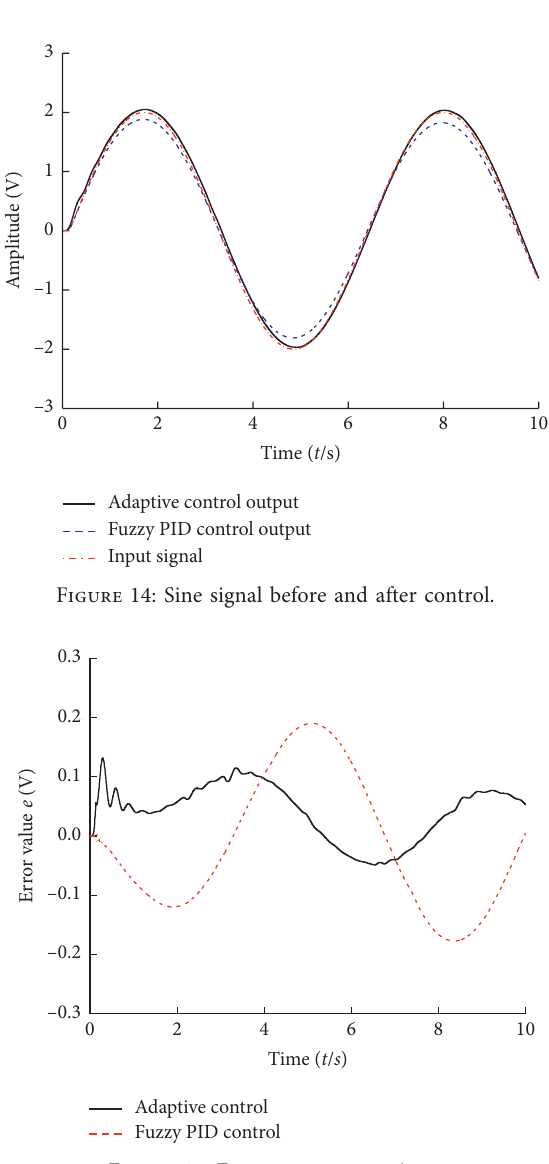
Figure 15: Error curve